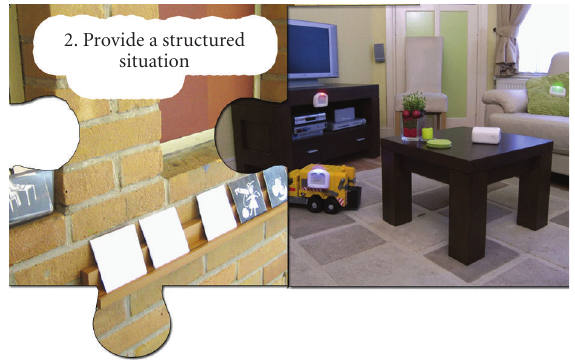
Figure 6: Structure: (a) a day-planner at a school for autistic children; activities are planned in time by means of pictograms. When an activity is completed, the pictogram is flipped over in order to provide structure. (b) An illustration of LINKX in a living room; the game is structured by means of speech-o-grams that have a fixed position, word, and colour.